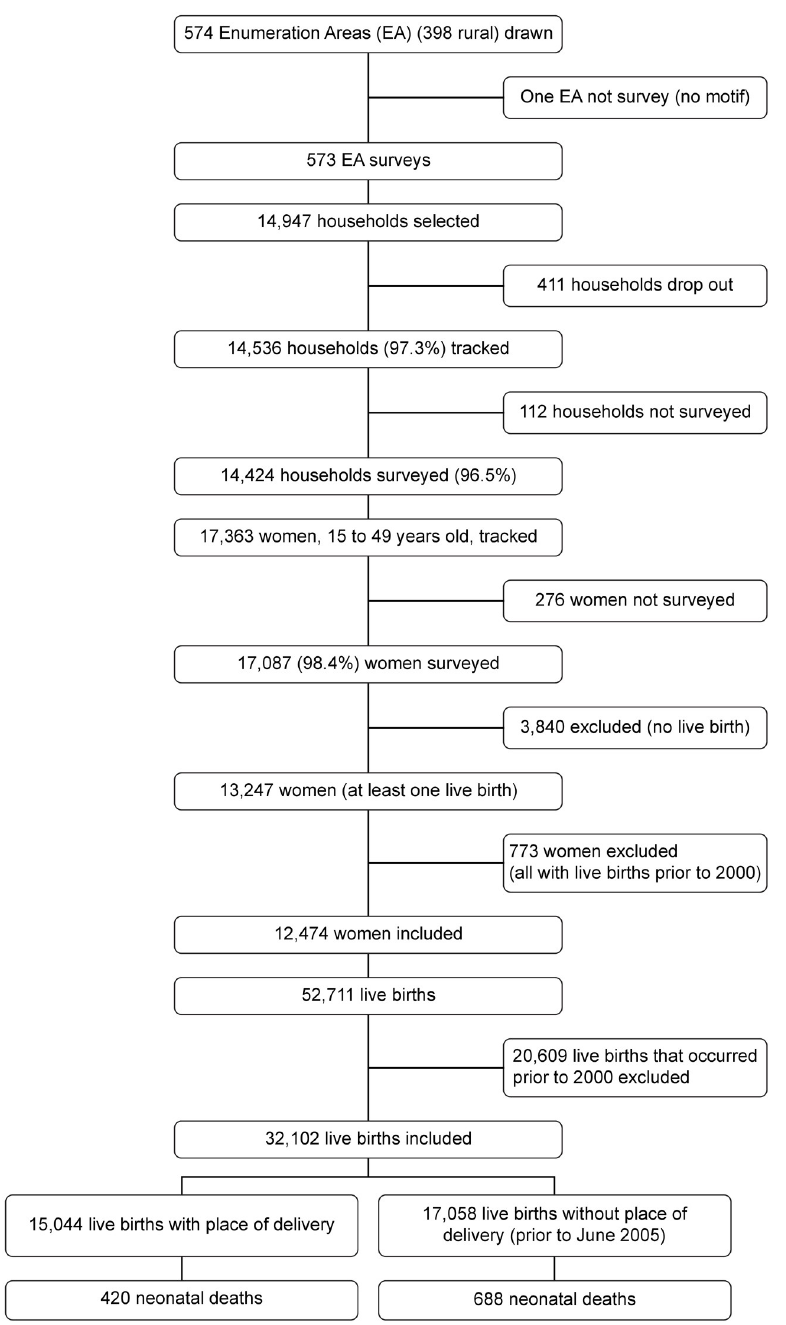
Fig 1. Flow diagram of the sample selection process used in the